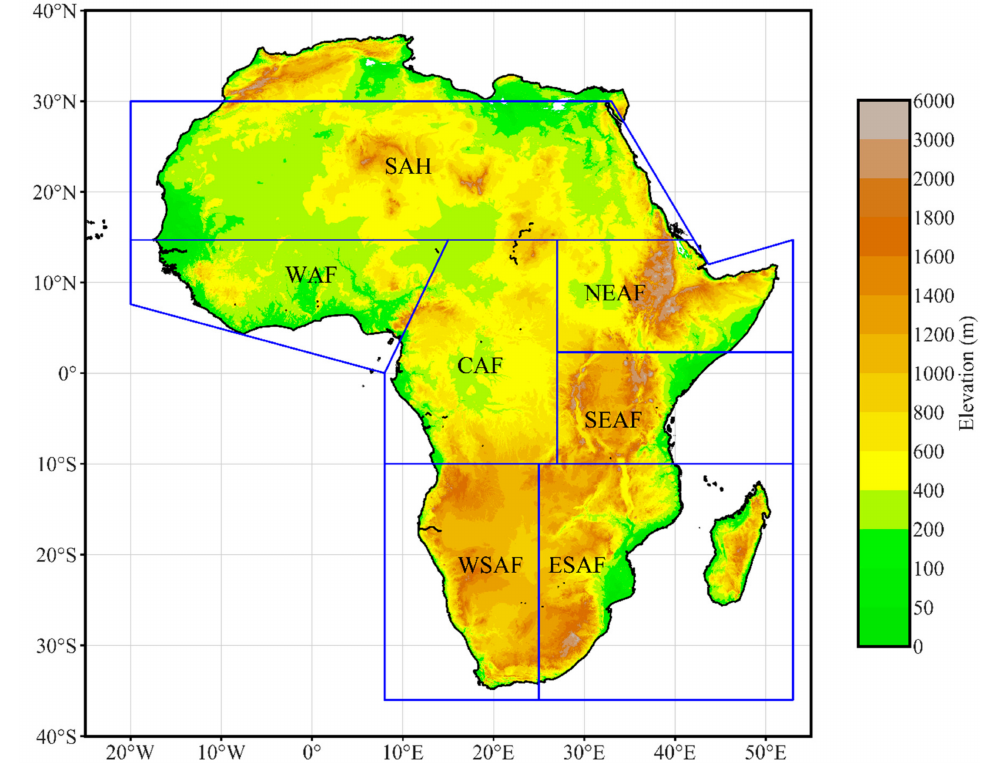
Figure 1. Topographical map of the African domain, overlaid with the updated IPCC key regions for subcontinental climate analysis